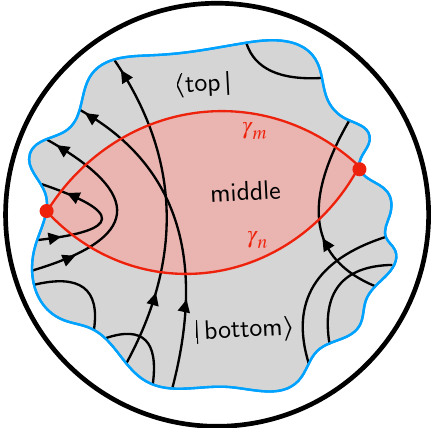
Figure 4 . Interpretation of the chord diagram as an overlap of a bra h top | and ket | bottom i defined in the bulk Hilbert space. The middle region (pink) defines an inner product between states. It is defined as a 1-way region: all chords entering through γ n must exit through γ m